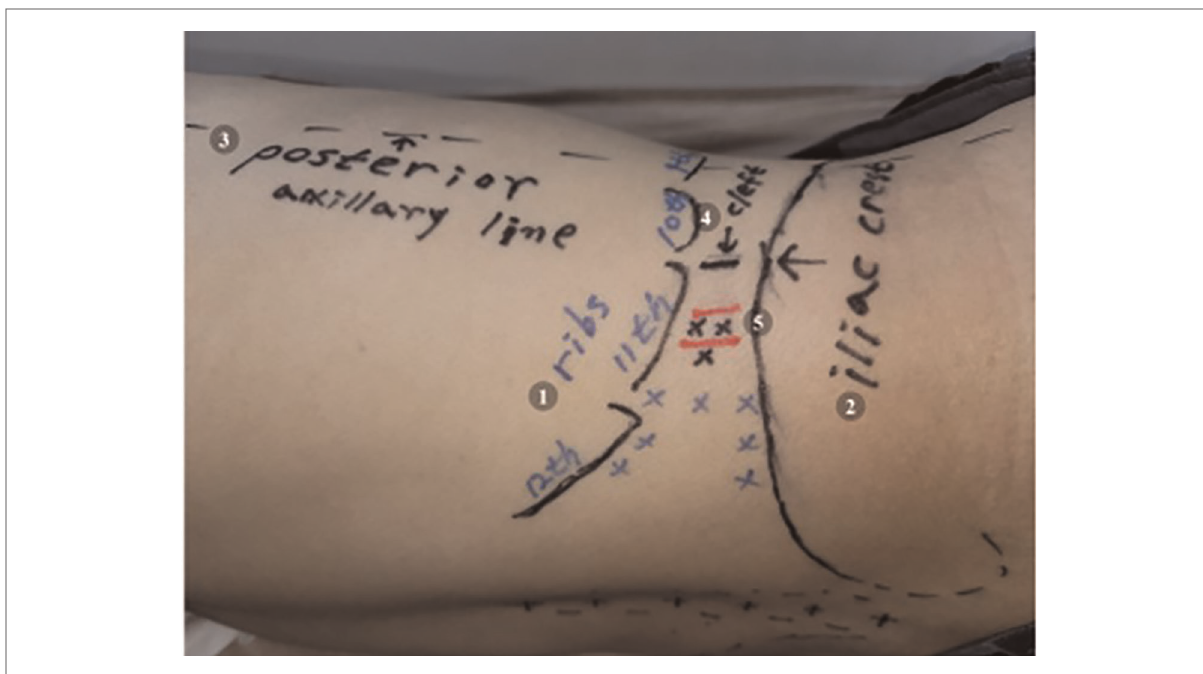
FIGURE 3 Five landmarks for an effective and safe procedure. The most important aspect of an effective and safe procedure is to check the fi ve landmarks accurately. (1) the contour of the tip of the twelfth rib and the lower margin, (2) the iliac crest, (3) the posterior axillary line, (4) the cleft between the fi rm or hard back muscle and the soft abdominal muscle, (5) the lumbar transverse process (located 1 cm – 1.5 cm behind the cleft) in thin patients. Black x marks denote the needle entry point when targeting deep fi ber TrPs, blue x marks denote the needle entry point when targeting super fi cial fi ber TrPs, and red lines denote the lumbar transverse process, which is generally located 1 cm – 1.5 cm posterior to the cleft described in (4). (The model in Figure 3. is one of the authors of this